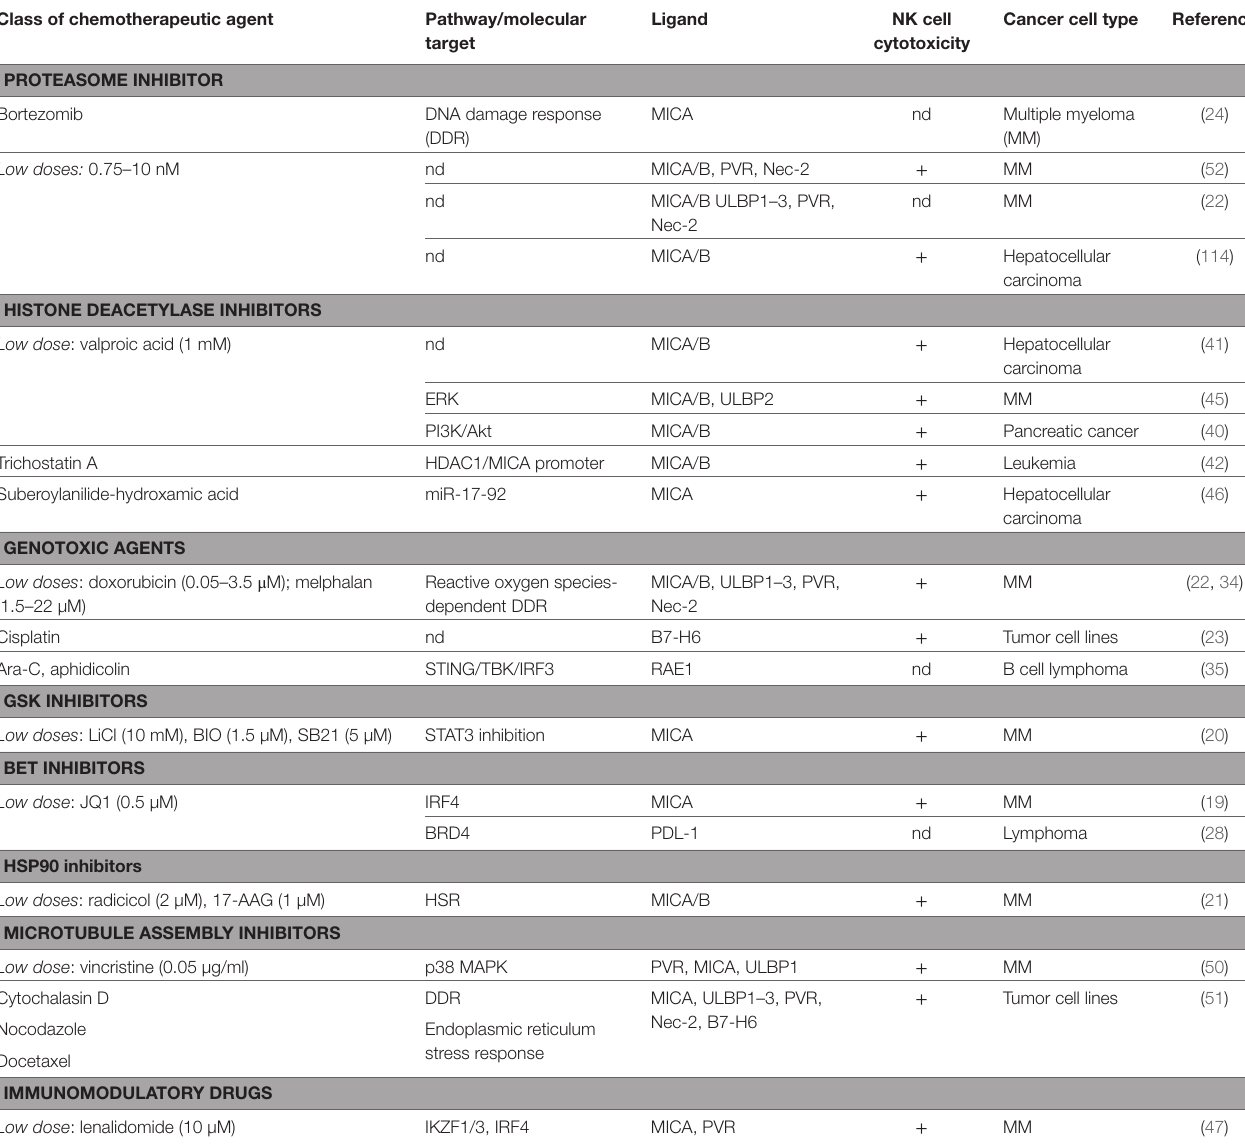
TABLe 1 | Chemotherapy-induced pathways and molecular targets able to modulate natural killer (NK) cell activating ligands and PDL-1 on cancer